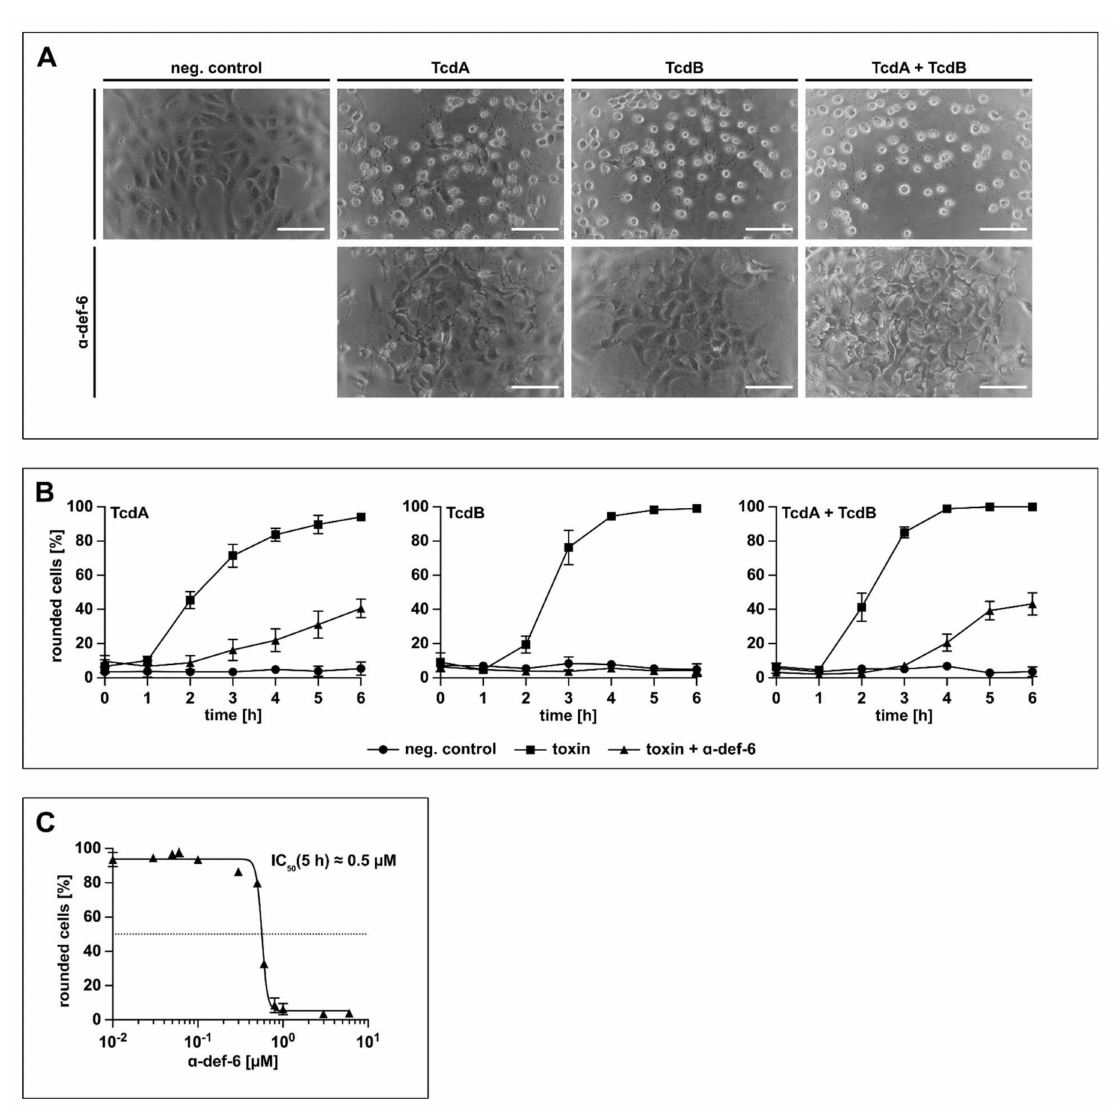
Figure 3. α -def-6 protects Vero cells from intoxication with TcdA, TcdB and the combination of both toxins. ( A ) Vero cells were intoxicated with TcdA (20 pM), TcdB (10 pM) or the combination of both toxins in the presence or absence of α -def-6 (6 µ M). For control, the cells were left untreated. Representative images after 6 h incubation time are shown ( n = 3). Scale bars correspond to 100 µ m. ( B ) Vero cells were treated as in ( A ). The amount of rounded, i.e., intoxicated cells was determined hourly. Values are given as mean ± SD of three technical replicates. Three biological replicates exhibited comparable intoxication and inhibition ( n = 3). ( C ) The concentration-dependent inhibition of TcdB (10 pM) was analyzed by incubating Vero cells with a concentration series of α -def-6 (ranging from 0.01 µ M to 6 µ M). After 5 h, images were taken, and the percentage of rounded cells was determined. Depicted is the mean ± SD of three technical replicates. Nonlinear fit was applied with GraphPad Prism via log(inhibitor) vs. response (variable slope, four parameters). Under this defined condition, an estimated IC 50 value of about 0.5 µ M was measured. The value was derived from three biological replicates, each with three technical replicates ( n =